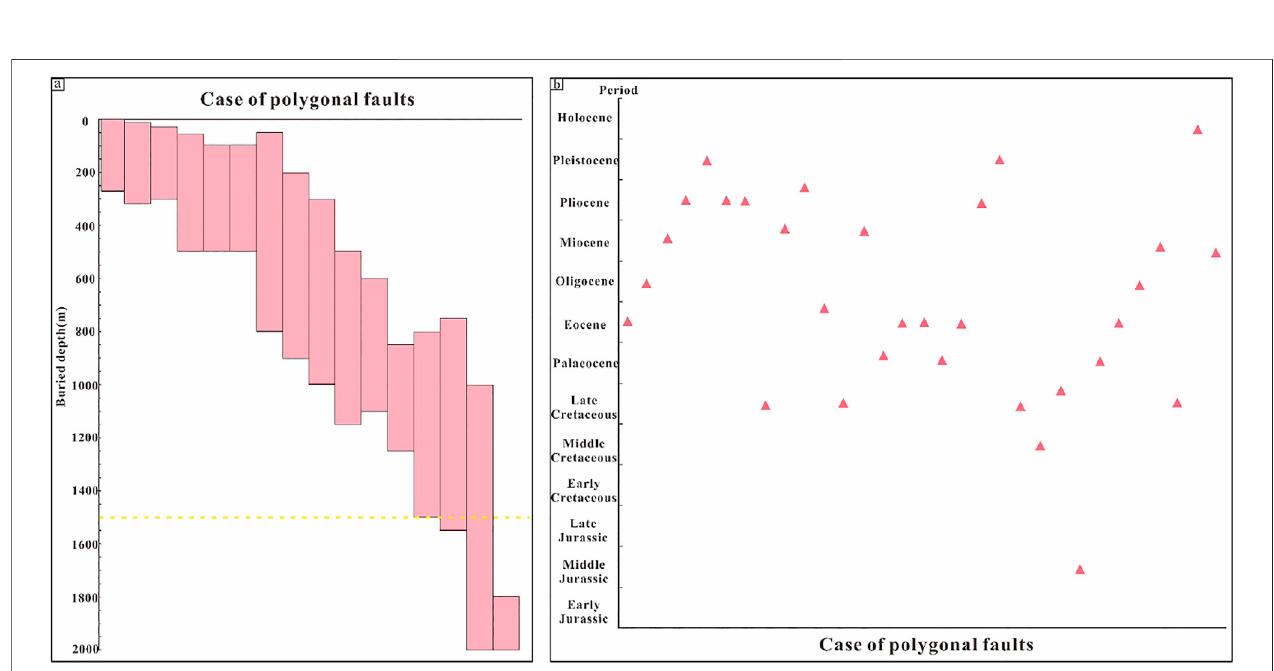
FIGURE 4 | (A) The buried depth below seabed of the PFs cases worldwide; (B) The development period of the global PFs case.